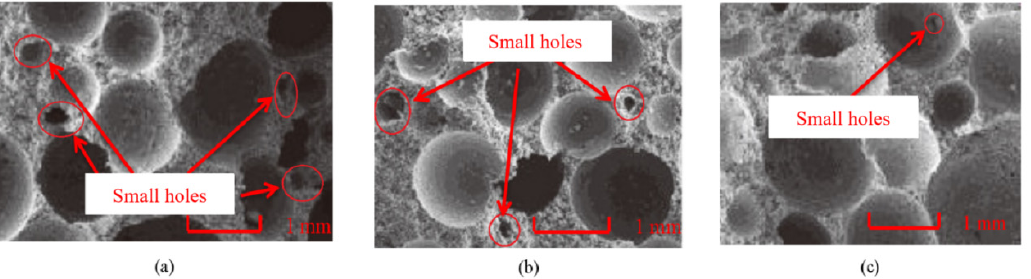
Figure 9. Microscopic images of small holes at the ages of 28 days with the sand-to-cement ratio ( R sc ) of 5 at the water-to-cement ratio ( R wc ) of ( a ) 0.65, ( b ) 0.85 and ( c ) 1.55.